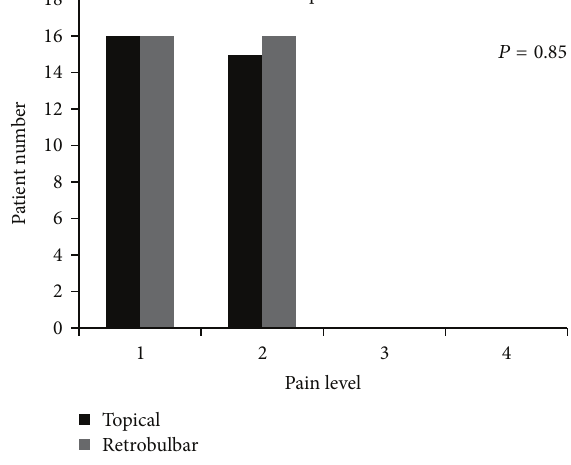
Figure 2: The pain scores recorded for surgery.